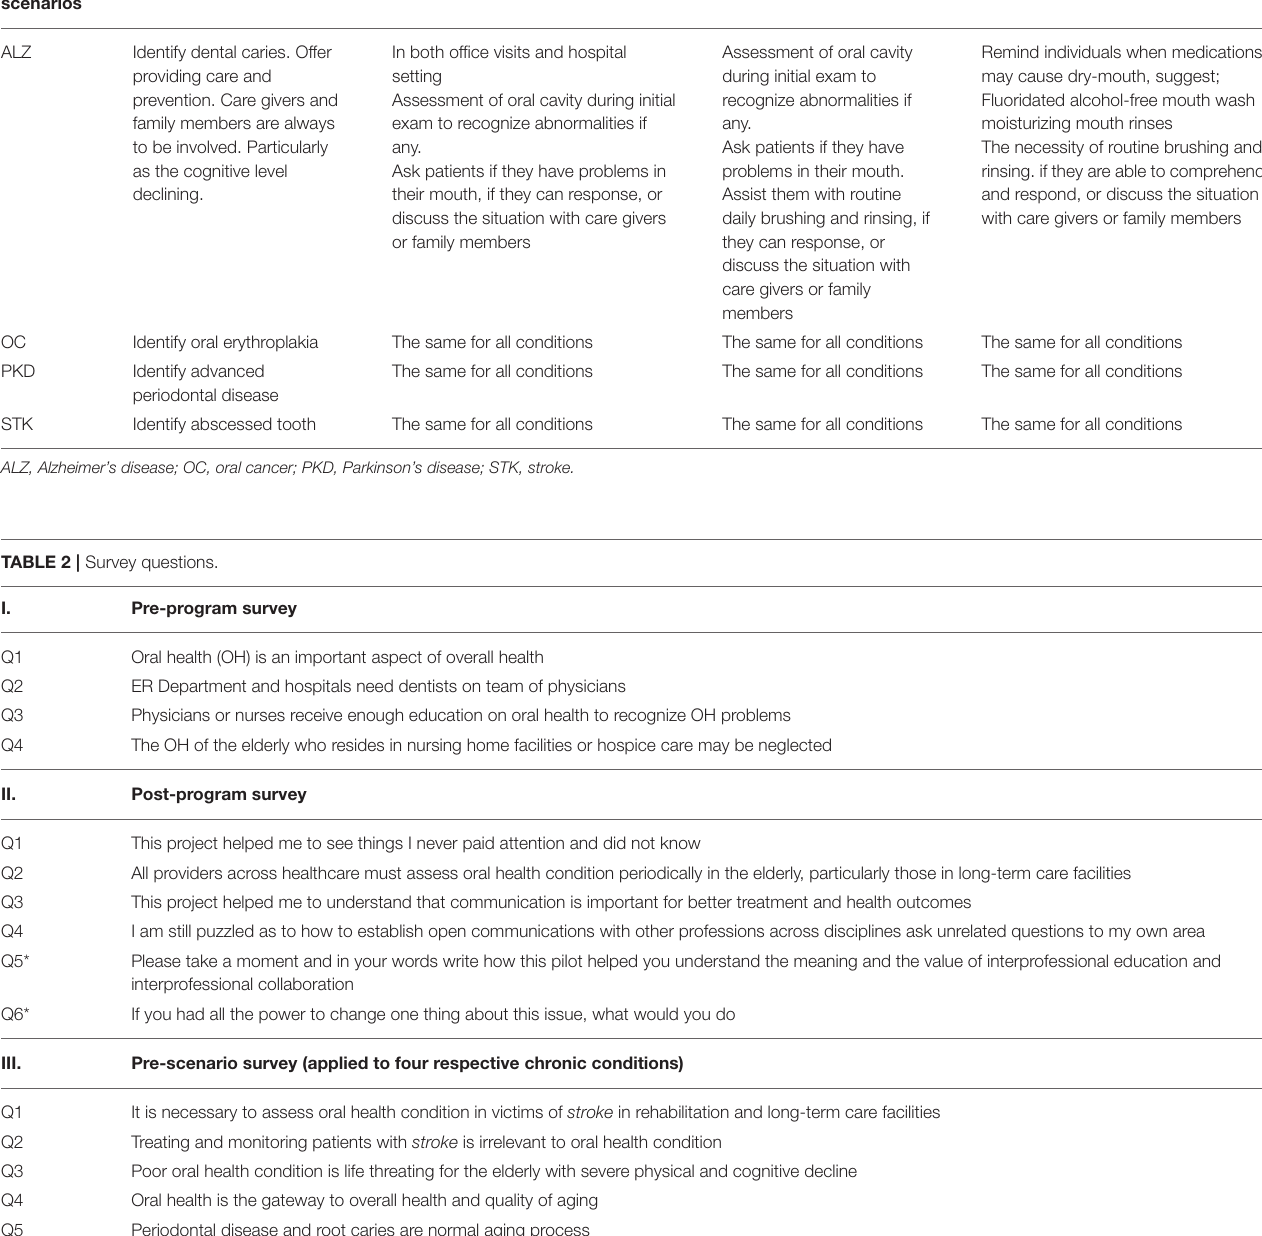
TABLE 1 | Individual roles and responsibilities in an interprofessional team. Disciplines/ scenarios